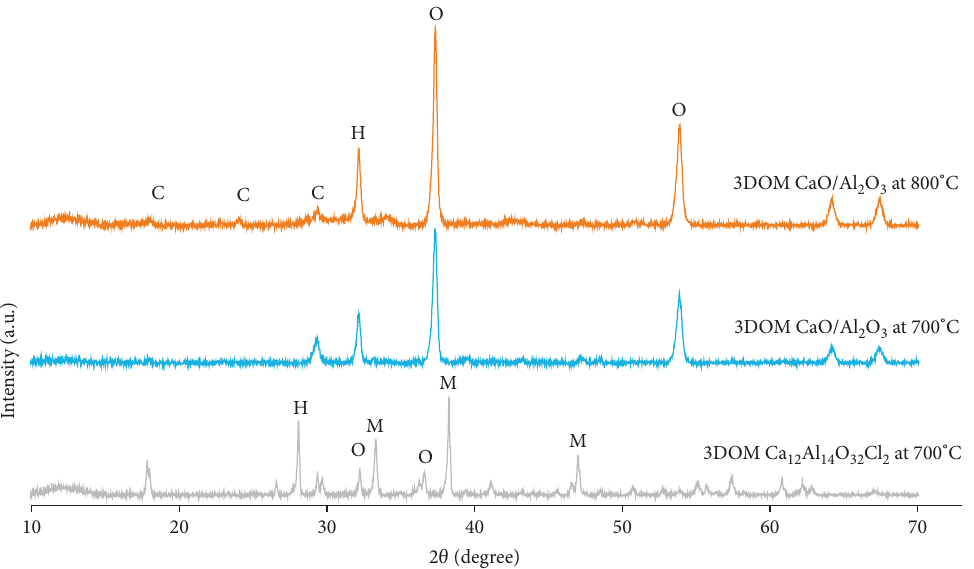
Figure 4: XRD patterns of the 3DOM CaO/Al and C CaCO 3 (cid:31)